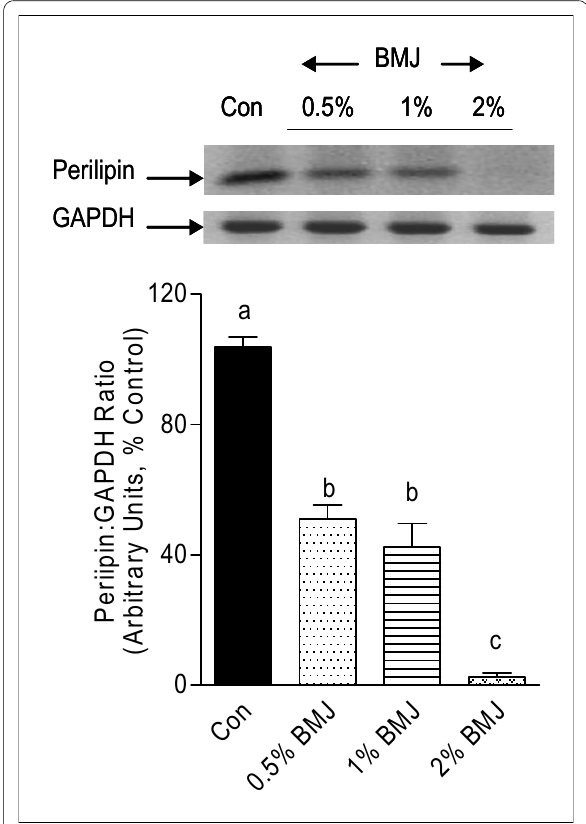
Figure 7 Effect of bitter melon juice on perilipin mRNA expres- sion . Adipocytes treated with varying concentrations of BMJ (0.5% to 2%, v/v) demonstrate a significant reduction in perilipin mRNA gene expression. Bar graphs depict the densitometry scans of 120-bp per- ilipin gene amplicons and are expressed as a ratio to GAPDH amplicon (298-bp) intensity. Data are expressed as a percentage of the control (set as 100%) and the values represent the mean ± SE (n = 6) of three independent experiments analyzed in duplicate. a, b, c Mean values with common letters do not differ (p <